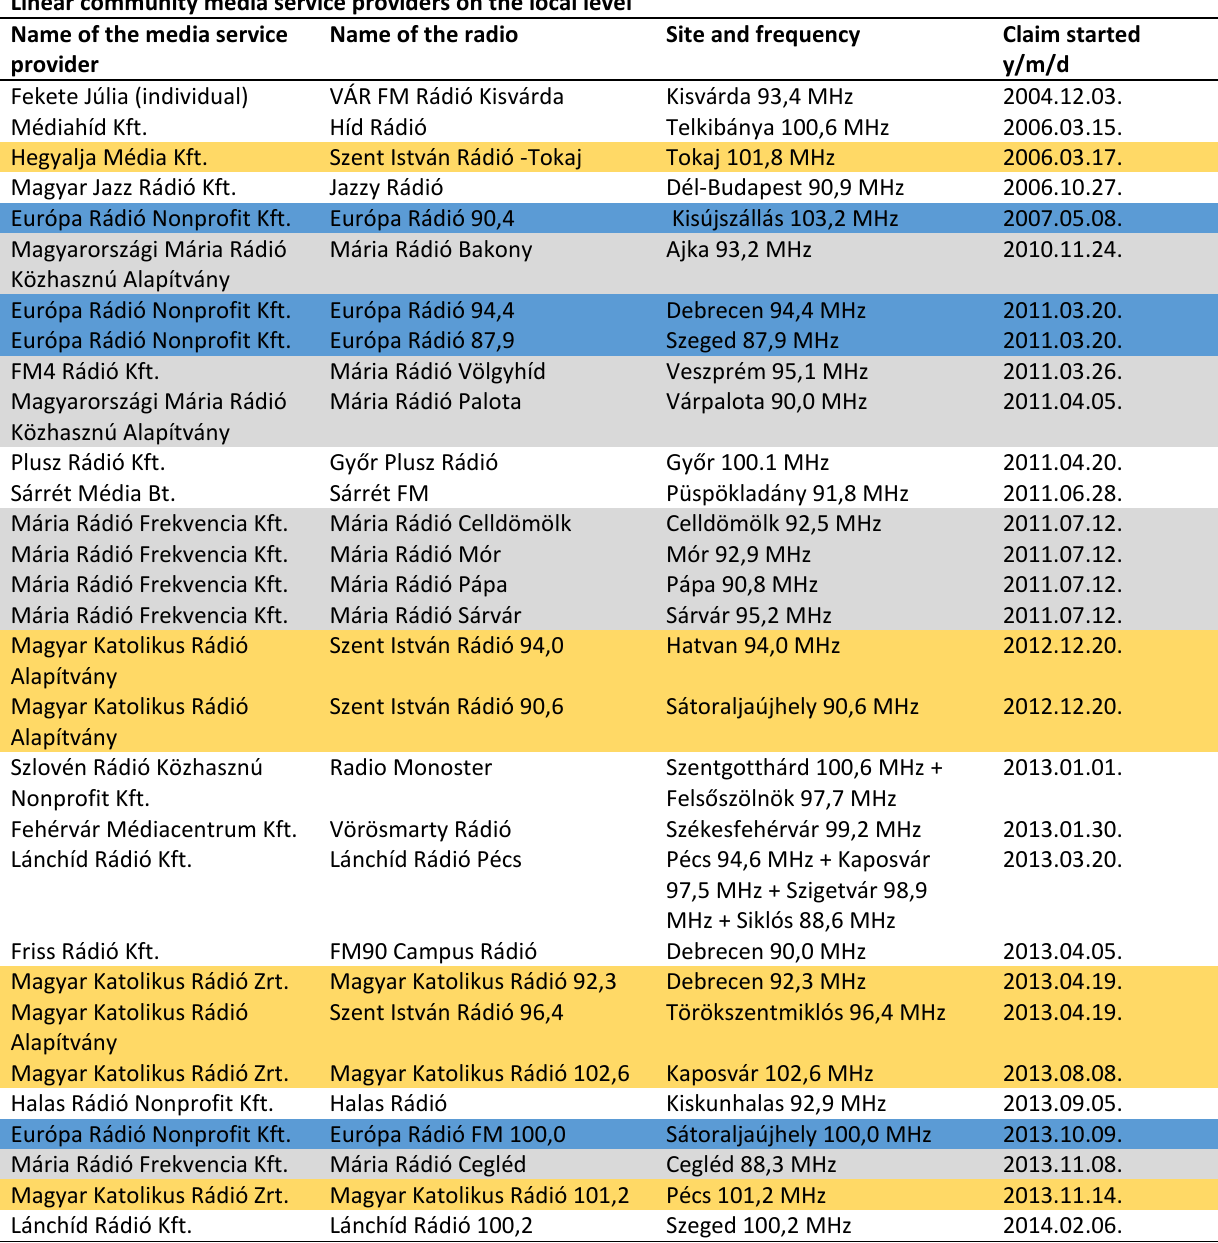
Table 3. Linear community media service providers on the local level. Linear community media service providers on the local